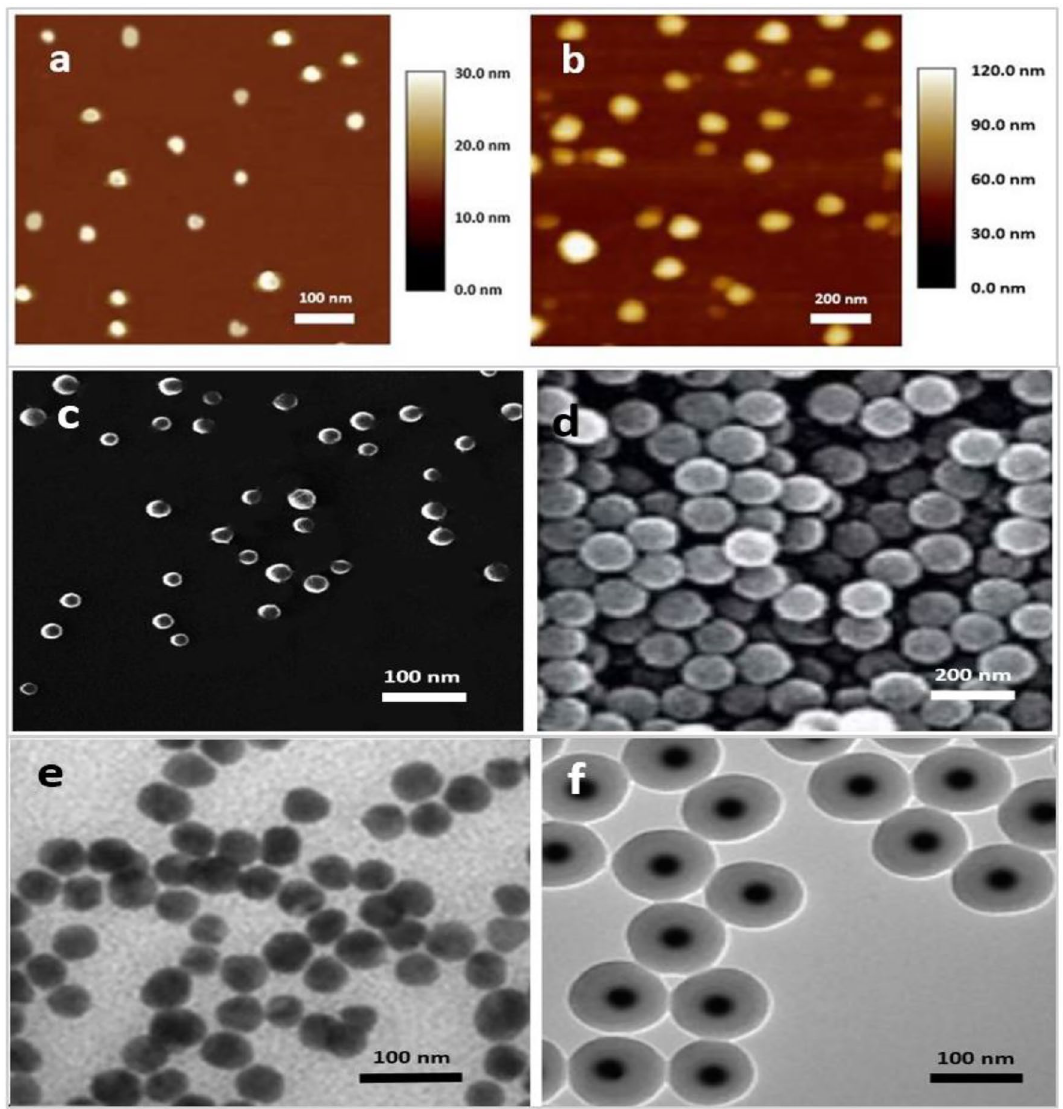
Figure 10. Characterization of SPIONs and SPION@Cs-PTX-PEG-FA nanoformulation with different techniques. ( a ), ( c ) and ( e ) are related to atomic force microscopy, scanning electron microscopy, and transmission electron microscopy images of SPION respectively and the ( b ), ( d ) and ( f ) are related to atomic force microscopy, scanning electron microscopy, and transmission electron microscopy images of SPION@ Cs-PTX-PEG-FA